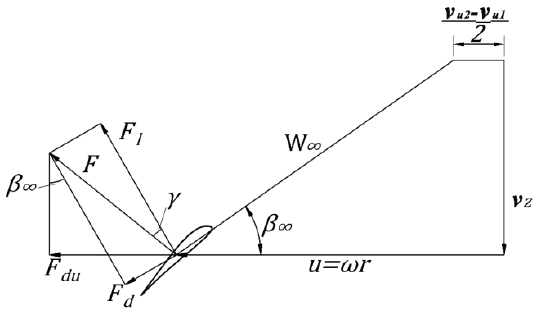
Figure 3. Velocity triangle of the rotor blade profile.